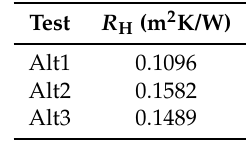
Table 6. Recalculated heat transfer resistance of the heat transfer layer of each experiment.